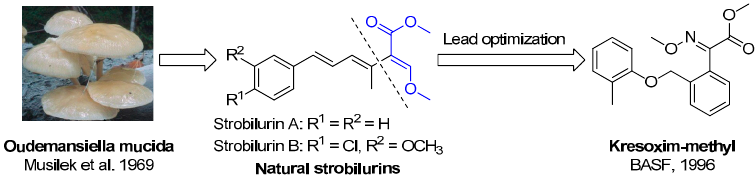
Figure 1. The discovery process of β -methoxyacrylates derivatives.